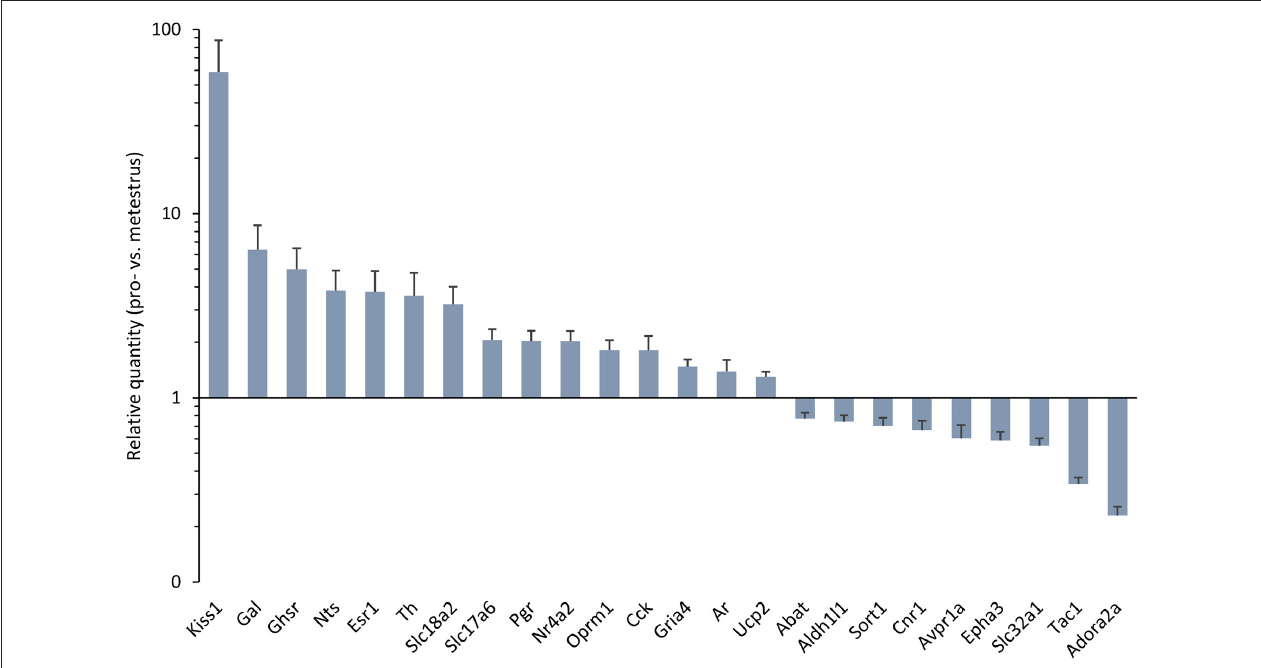
FIGURE 1 | Differentially expressed genes in the antero-ventral periventricular/medial preoptic area (MPOA) of the late proestrous mouse. Relative quantity (RQ) values indicate the relative expression of genes in the pro- vs. metestrous experimental groups ( p < 0.05, Student’s t -test). RQ values are visualized as a graph with log10 scale on the y axis.